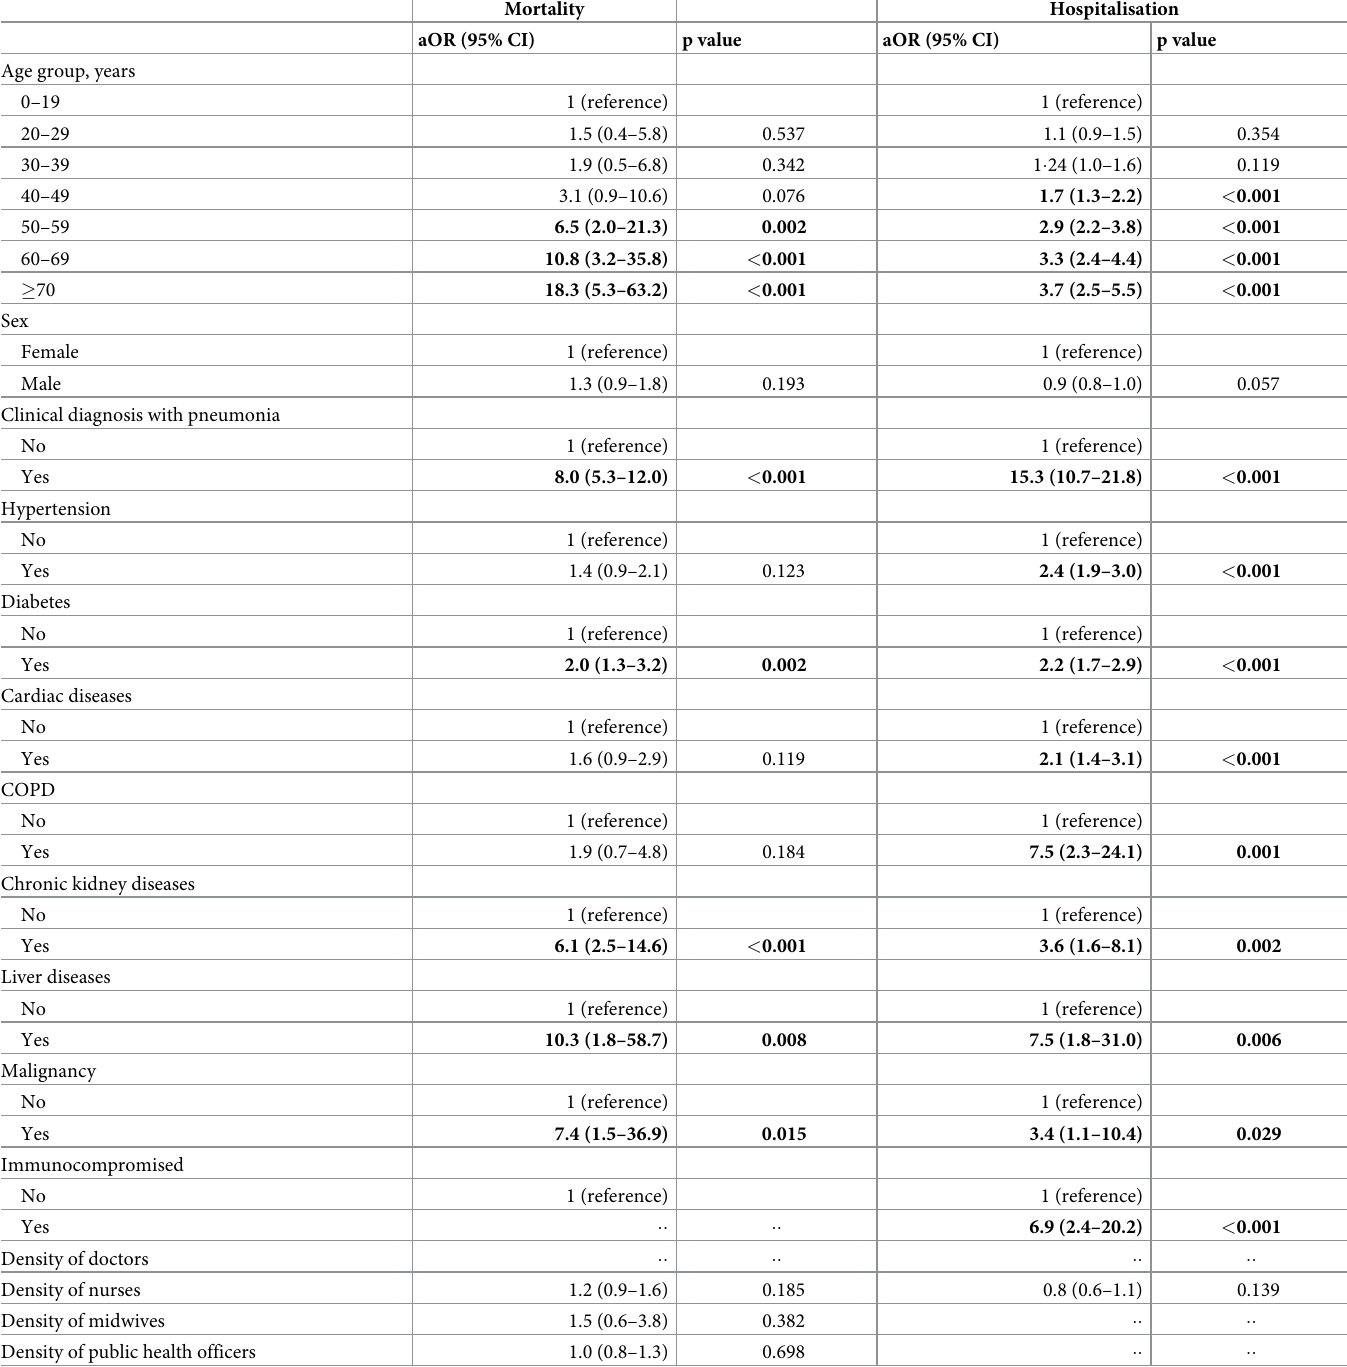
Table 3. Mixed effects logistic regression multivariable models showing factors associated with risk of COVID-19 mortality and hospitalisation in five rural prov- inces in Indonesia, 1 January to 31 July